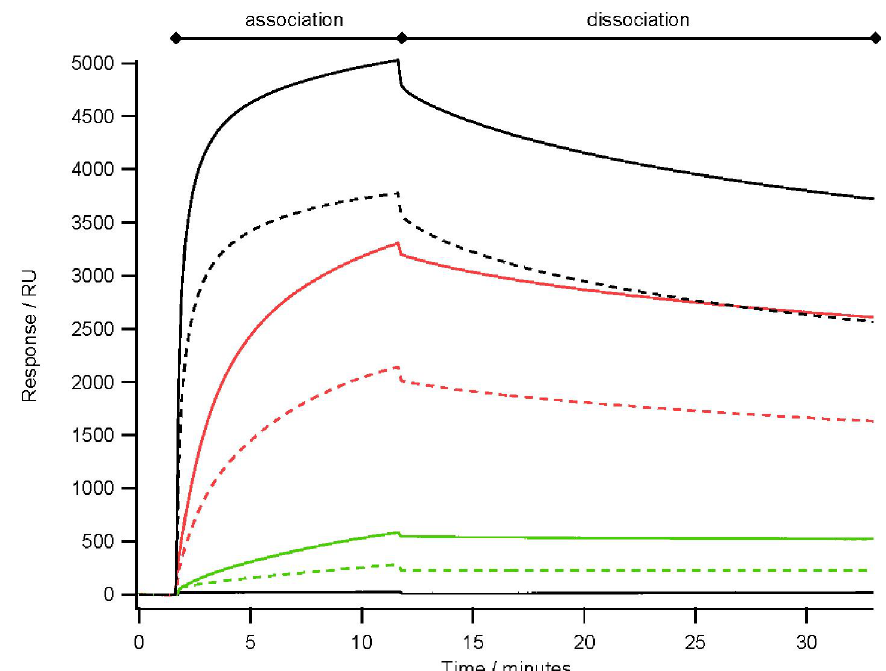
Figure 5. The binding of mouse monoclonal IgG2a to an array of ZZlinkZZctOmpA (solid traces) and ZZctOmpA (dashed traces) over a range of antibody concentrations. The antibody concentrations used were 480 nM (black), 40 nM (red) and 5 nM (green). A PBS only injection is also shown with 0 RU response. The antibody in PBS was flowed over the array at 10 μL min −1 and had a total contact time of 10 min before a dissociation time of 20 min. The array was regenerated with 100 mM glycine pH 2.0 between each antibody